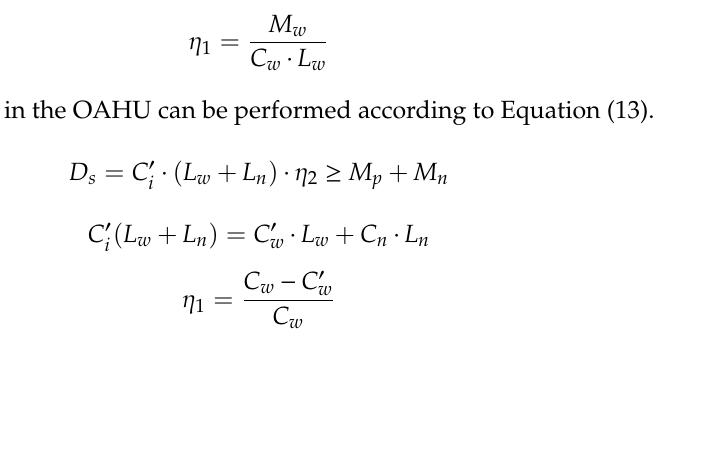
outdoor air PM2.5 outdoor air PM2.5 load.